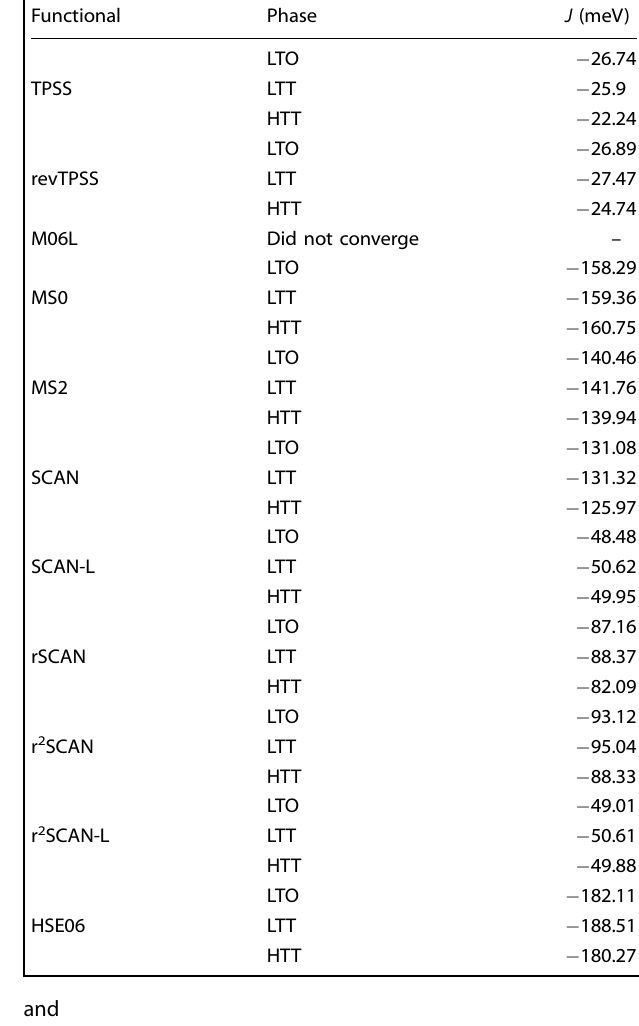
Table 1. Theoretically predicted values of U and J H using various DFAs for three different phases of pristine LCO. Functional